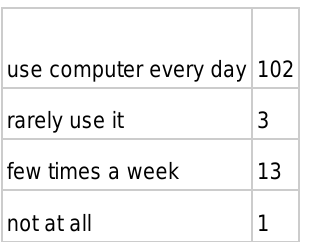
Table 3 . Technology readiness levels (survey)